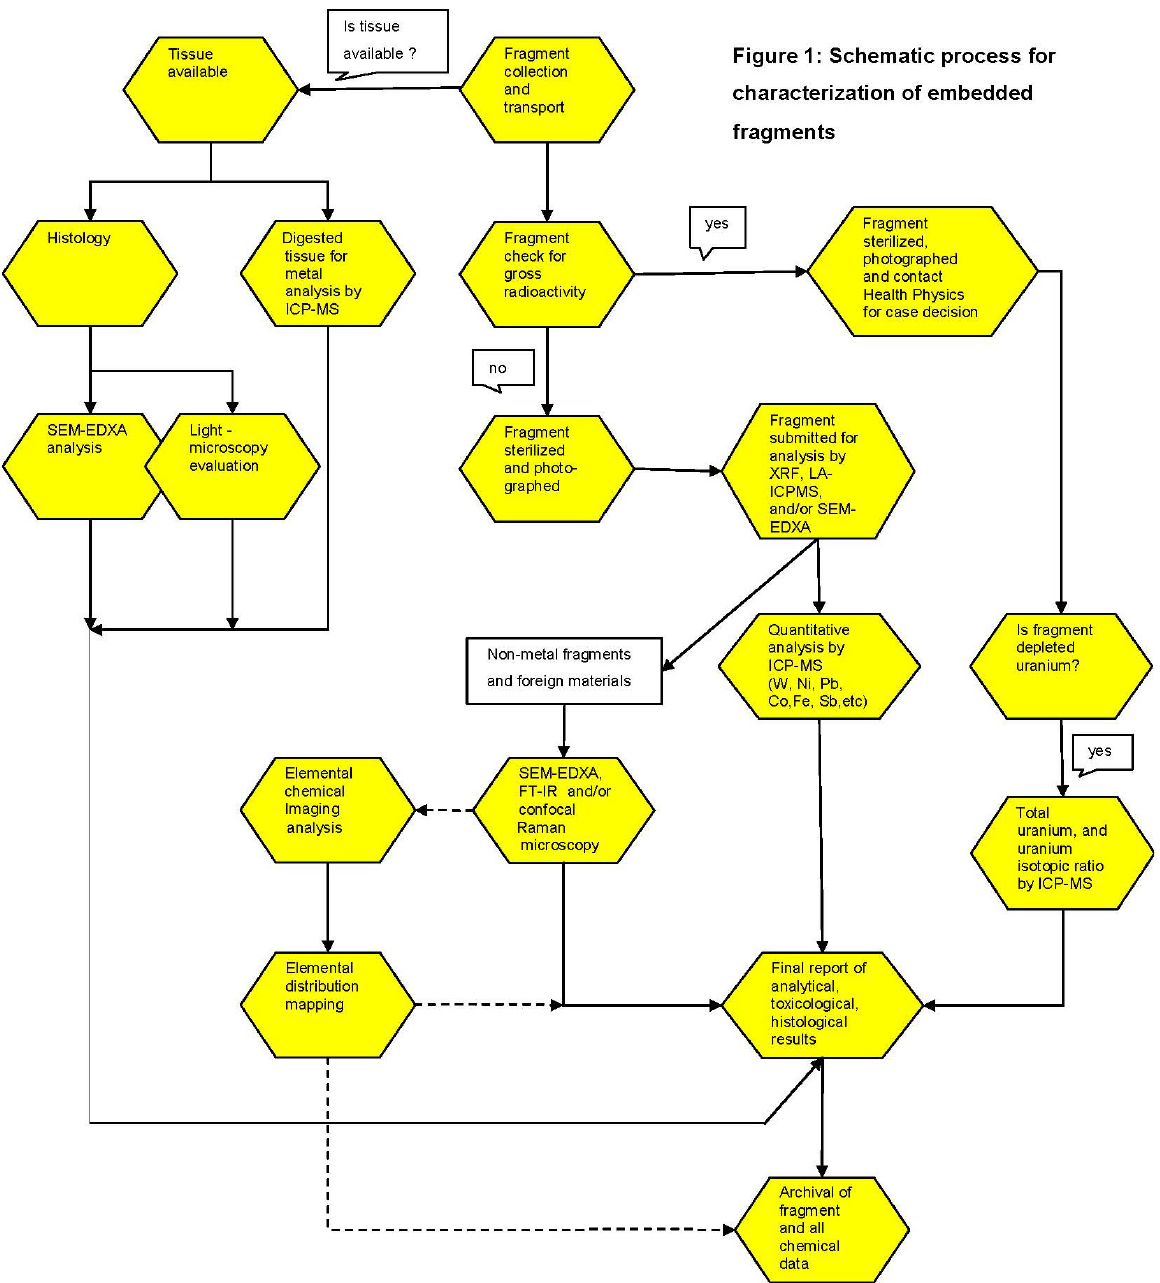
Figure 1. Schematic process for characterization of embedded fragments as performed by the Joint Pathology Center (JPC) Embedded Fragment Registry. The process steps connected by black arrows are always performed; the steps connected by dotted arrows are only taken when considered